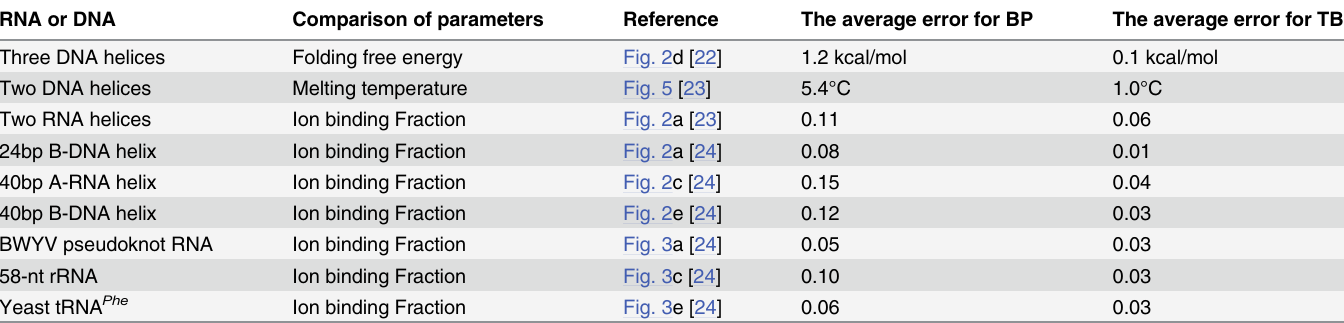
Table 1. Comparison between the TBI and the Poisson-Boltzmann predictions and test against experimental data. RNA or